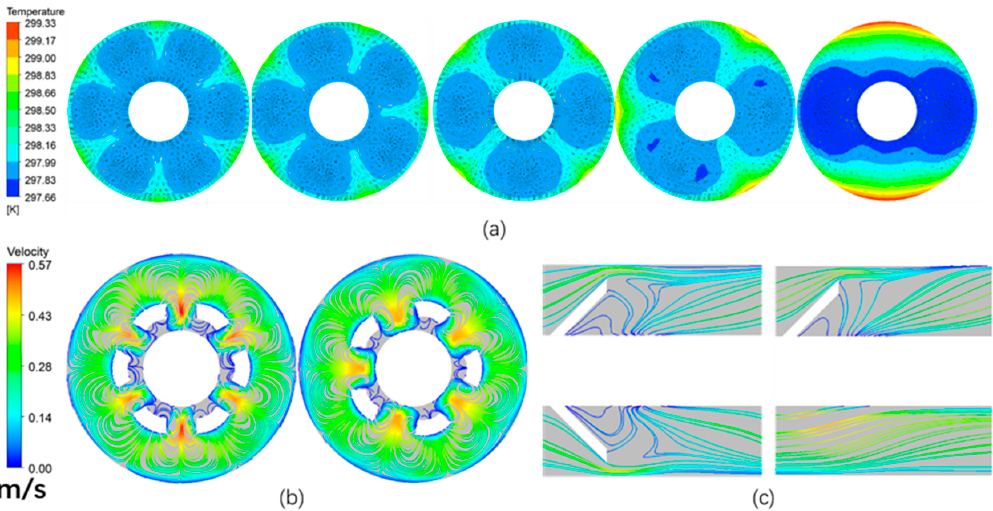
Figure 7. Temperature contour and streamline:( a ) temperature distribution at two, three, four, five, six blades on plane at z = 51 mm (P = 3 mm, A = 45°), 𝑅𝑒 = 20; ( b ) streamline on plane at z = 50.4 mm (P = 3 mm, A = 45°, N = 6 (left), N = 5 (right), 𝑅𝑒 = 600); ( c ) streamline on YZ plane (P = 3 mm, A = 45°, N = 6 (left), N = 5 (right), 𝑅𝑒 = 600).